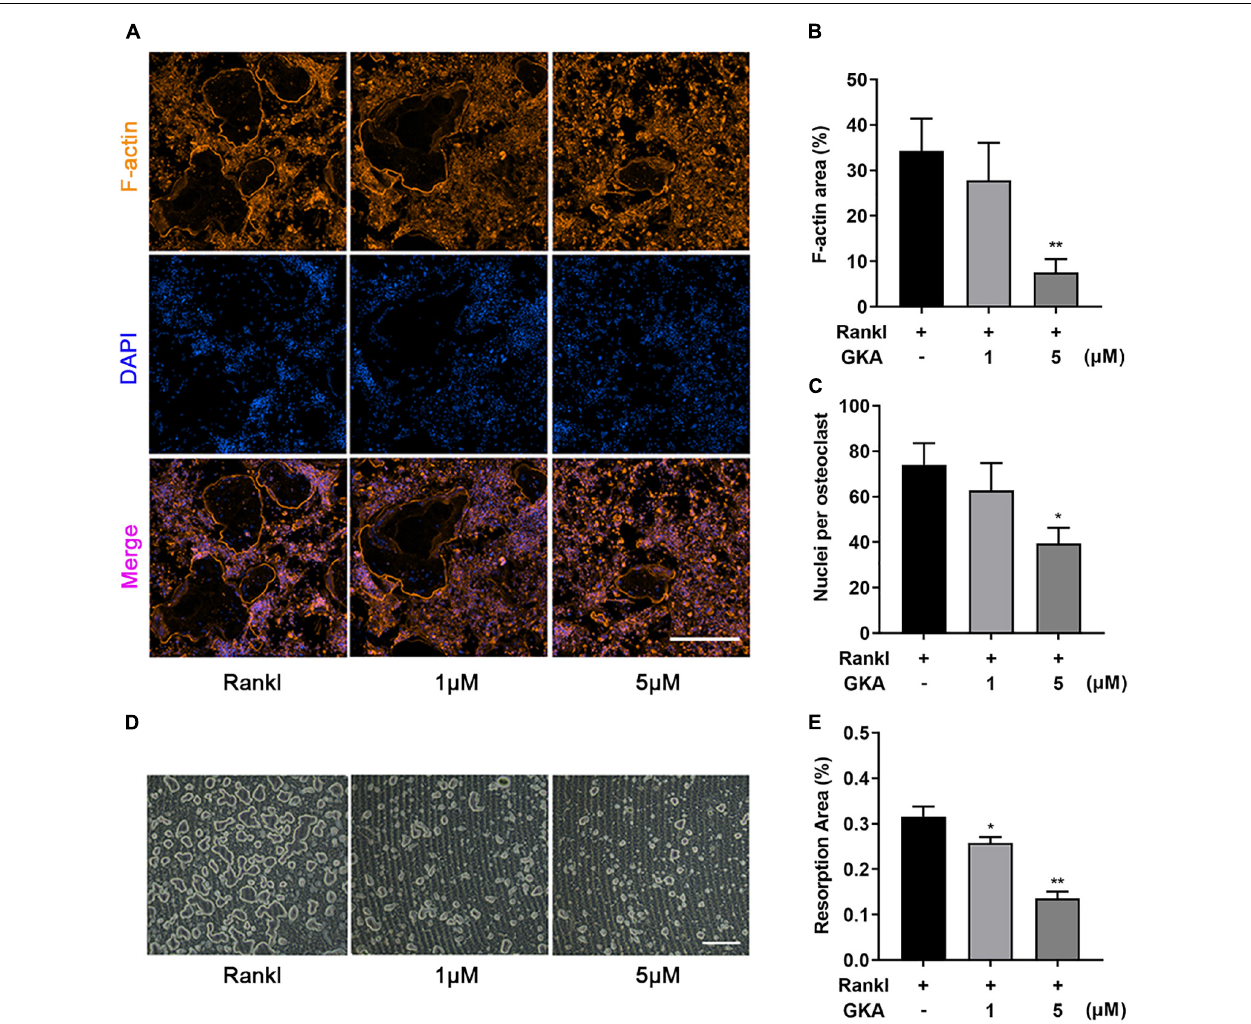
FIGURE 3 | GKA attenuated RANKL-induced osteoclast fusion and bone resorption in vitro . (A) Representative images of BMMs stained for F-actin and nuclei with Phalloidin-iFluor 488 and DAPI (scale bar, 500 µ m). (B) Quantification of F-actin area per well. (C) The average number of nuclei per osteoclasts. (D) Representative images of bone resorption (scale bar, 500 µ m). (E) The resorption areas were detected using the ImageJ software. The data were illustrated as the Mean ± SD (* P < 0.05, ** P < 0.01, compared with the control group; n = 3, analyzed by one-way ANOVA).